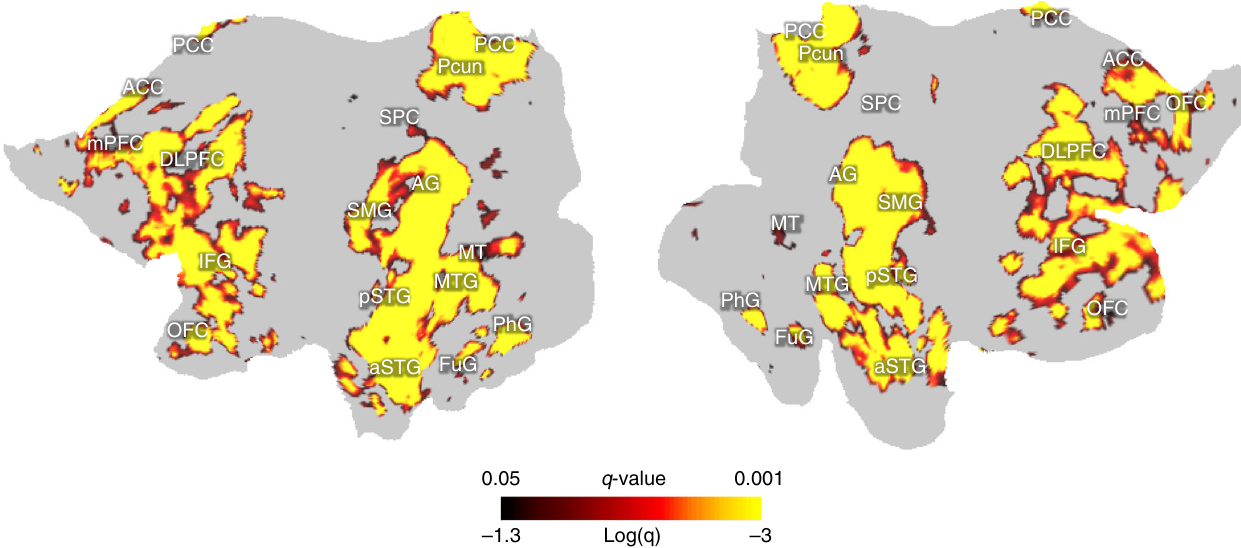
Fig. 2 A map of the semantic system obtained by 10-fold cross-validation of the encoding model. The map is displayed on the fl attened cortical surfaces for the left and right hemispheres. The color indiciates the FDR (or q value) in a logarithmic scale. The highlighted areas include voxels where cross- validation results are statistically signi fi cant (block-wise permutation test, one-sided, q < 0 : 05). Anatomical labels are shown to relate the model-predictable areas to cortical regions prede fi ned in a connectivity-based atlas 27